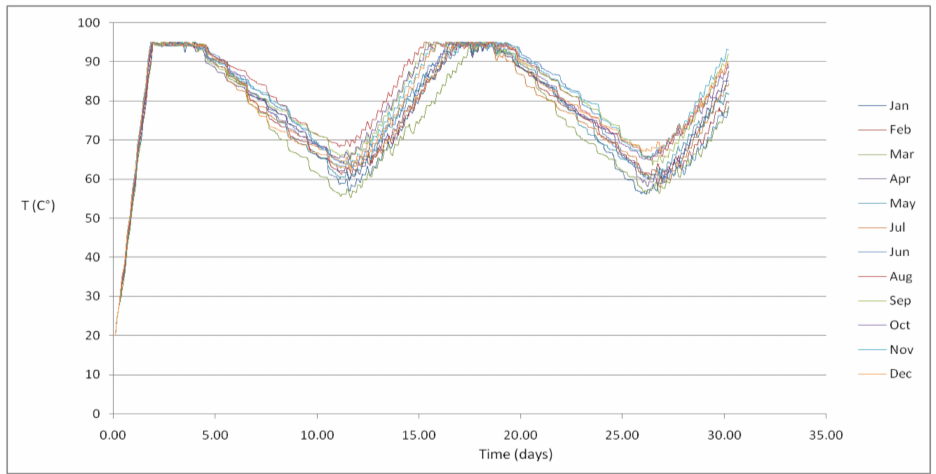
Figure 14. The temperature in the 15 m 3 HWT for energy demand for 10 families (Case 2a).